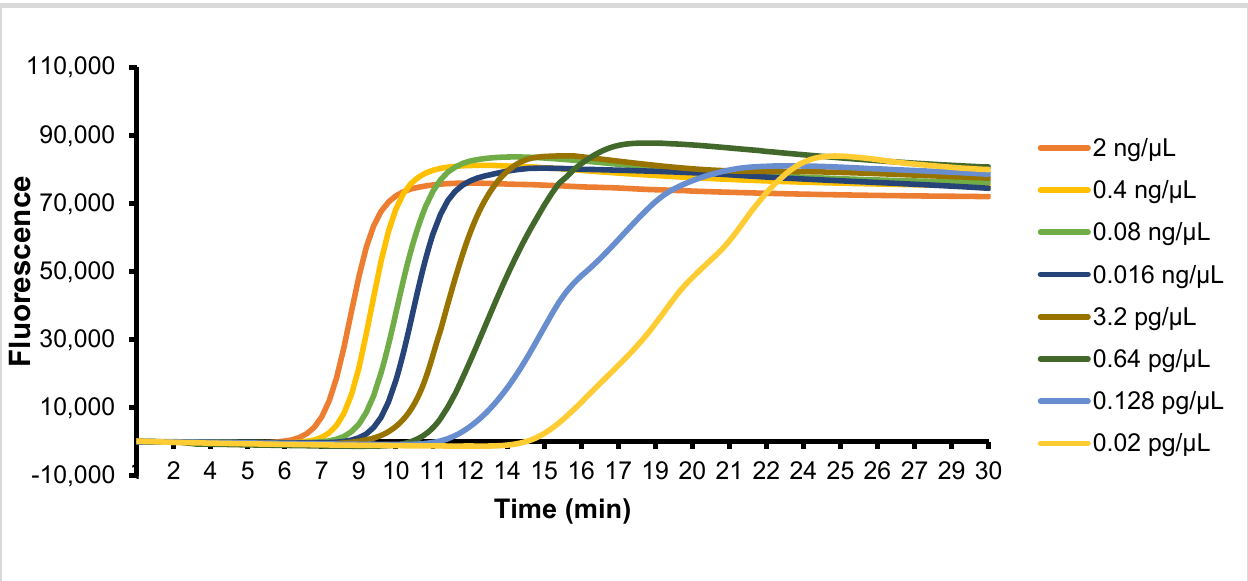
Figure 1. Fluorescence of EAB DNA in a 1:5 serial dilution to determine the lower detection threshold of the EAB LAMP assay.